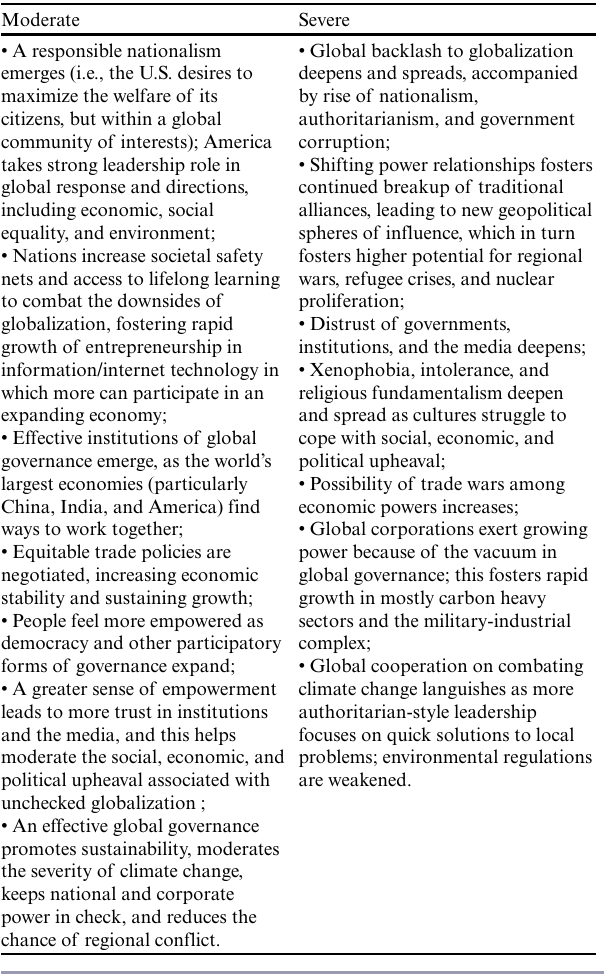
Table 3 . Characterizations of moderate and severe changing world order used to develop alternative future scenarios for the Lowcountry of South Carolina.